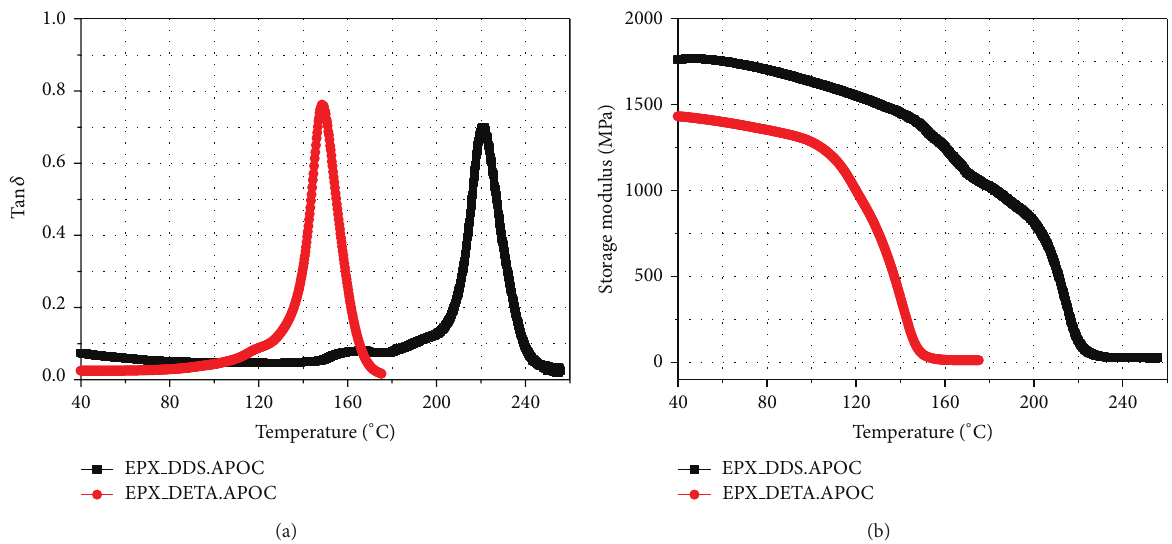
Figure 4: (a) Tan 𝛿 and storage modulus; (b) Tan 𝛿 as a function of the temperature for DGEBA/DDS and DGEBA/DETA epoxy system.